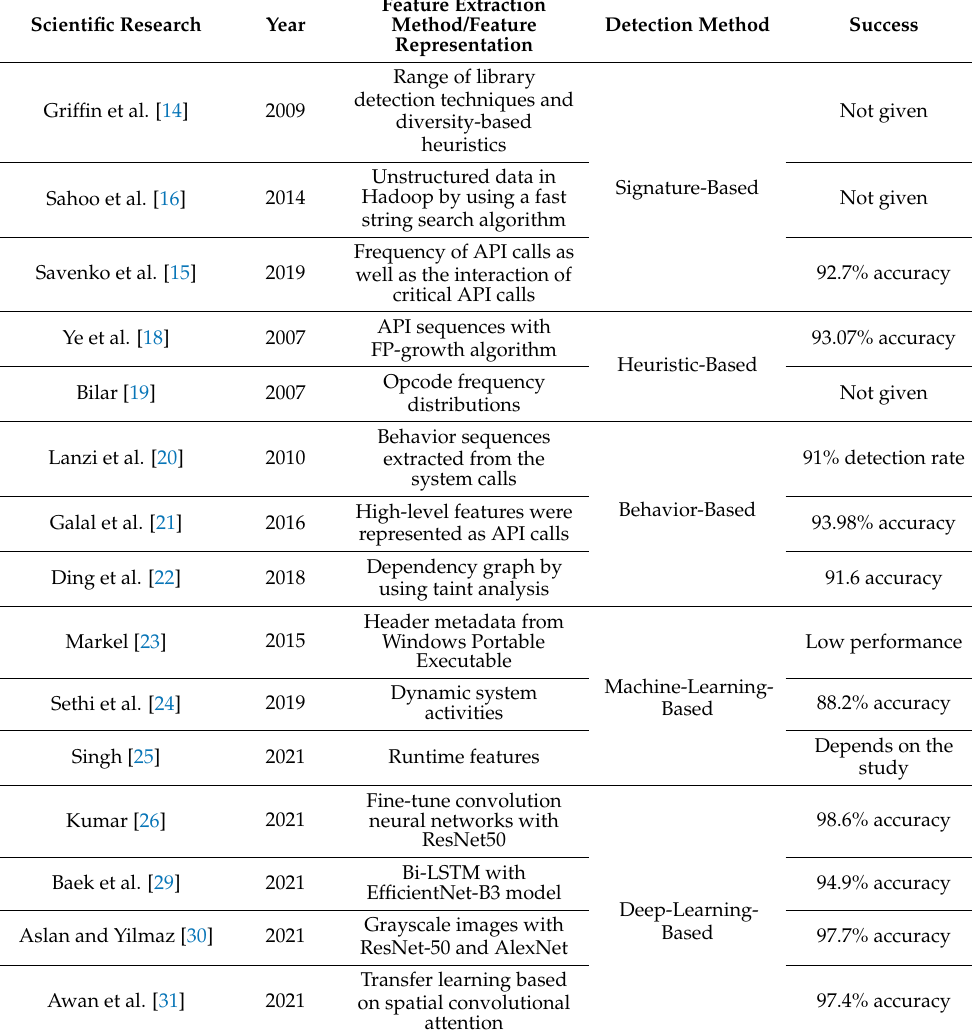
Table 2. The summary of the state-of-the-art studies on malware detection and classification methods. Scientific